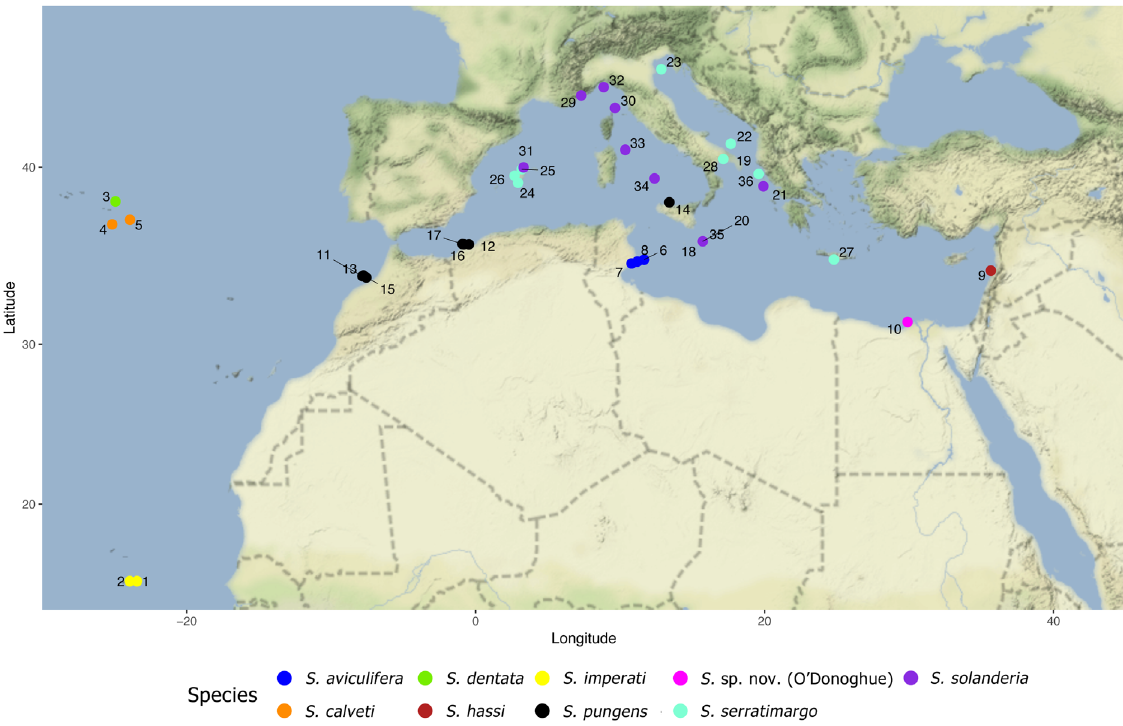
Fig. 12. Distribution of specimens studied: Schizoretepora imperati (1 = Retepora imperati , syntype (NHMUK 1934.2.16.23); 2 = Retepora imperati , syntype (NHMUK 1963.2.12.202)); Schizoretepora dentata (3 = Schizellozoon dentatum , holotype (MOM INV-22494-42 0559)); Schizoretepora calveti (4 = S. calveti , lectotype (MNHN-IB-2008-7565); 5 = Schizellozoon tesselatum Hincks var. nov. Calvet, 1931); Schizoretepora aviculifera (6 = Schizellozoon aviculiferum (MNHN-IB-2008-11126) and Schizellozoon longisetae (MNHN-IB-2008-11127); 7 = Schizellozoon granulosum , syntype (MNHN- IB-2014-21); 8 = Schizellozoon aviculiferum , holotype (MNHN-IB-2014-24)); Schizoretepora hassi (9 = Harmelin et al. 2007); Schizoretepora sp. nov . (= S. imperati sensu O’Donoghue & de Watteville 1939) (10 = S. imperati (NHMUK 1963.9.4.12)); Schizoretepora pungens (11 = S. longisetae , lectotype (MNHN-IB-2014-19); 12 = Retepora imperati (NHMUK 1911.10.1.813); 13 = S. pungens , syntype (MNHN-IB-2014-20); 14 = Retepora imperati (NHMUK 1911.10.1.1374); 15 = Retepora imperati (MNHN-IB-2014-29); 16 = Retepora imperati (MNHN-IB-2008-6052); 17 = S. imperati (MNHN- IB-2008-11299); 18 = S. imperati in Rosso et al. 2010); Schizoretepora serratimargo (19 = Hincks 1886; 20–23 = Rosso et al. 2010; 24–27 = Harmelin et al. 2007; 28 = Reverter-Gil & Pulpeiro 2007); Schizoretepora solanderia (29 = Risso 1826; 30 = Calvet 1902; 31 = S. solanderia (MZB 2014-1471); 32–36 = Rosso et al.